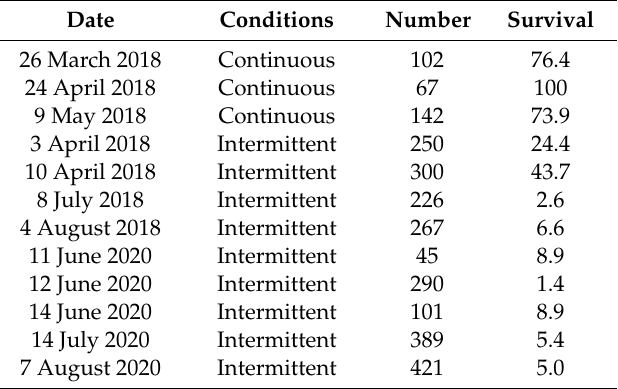
Middle Rio Grande, New